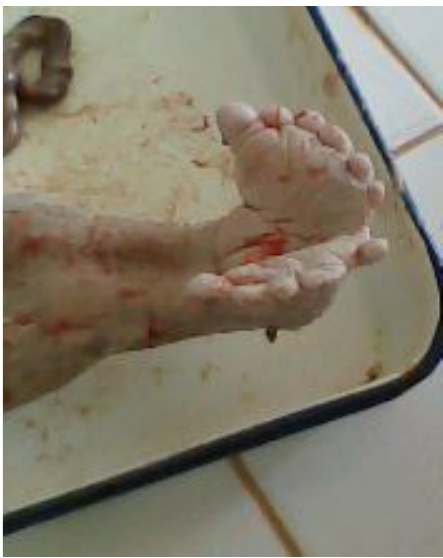
Figure 6. Photograph showing the fused feet with 11